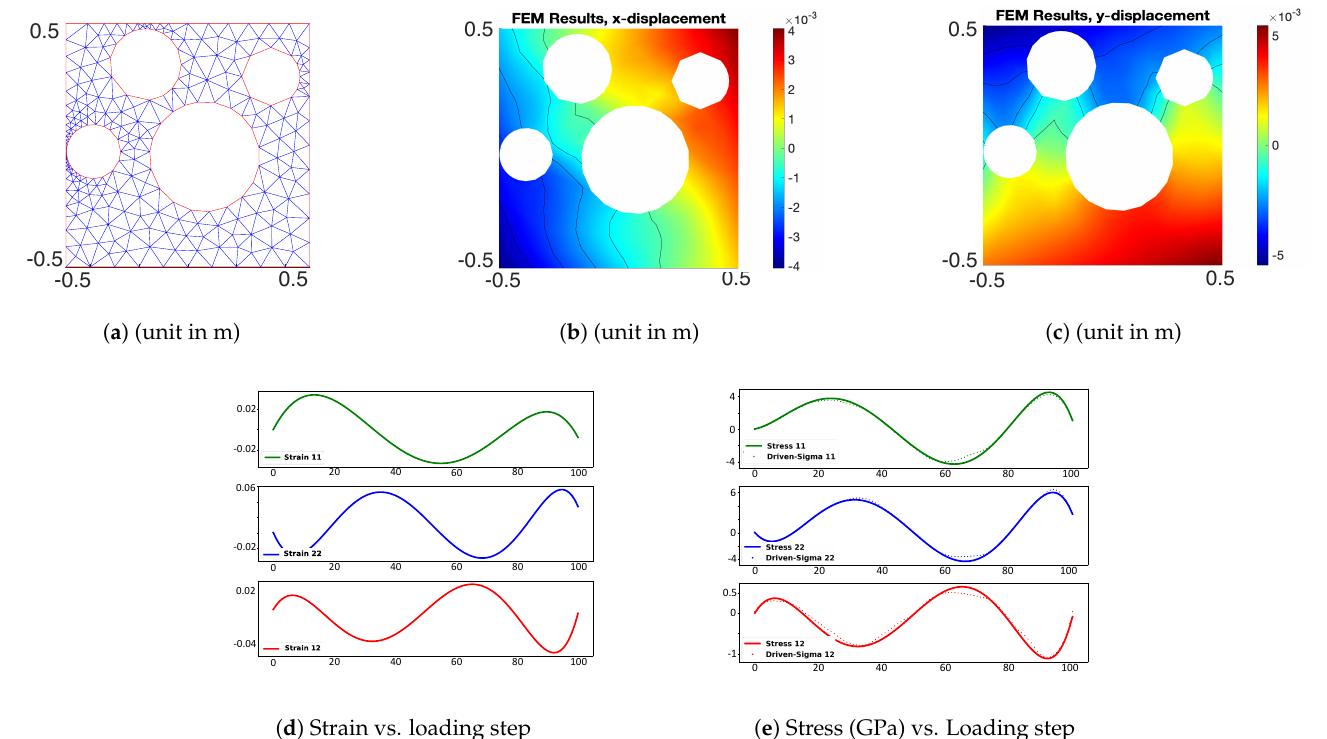
Figure 7. Test 1 for homogenization of linear elastic microstructure ( µ = 25 GPa and λ = 200 GPa), ( a ) FEM mesh, ( b ) X displacement (initial step), ( c ) Y displacement (initial step), ( d ) random generated strain, and ( e ) comparison of homogenized effective stress and Data-Driven responses.